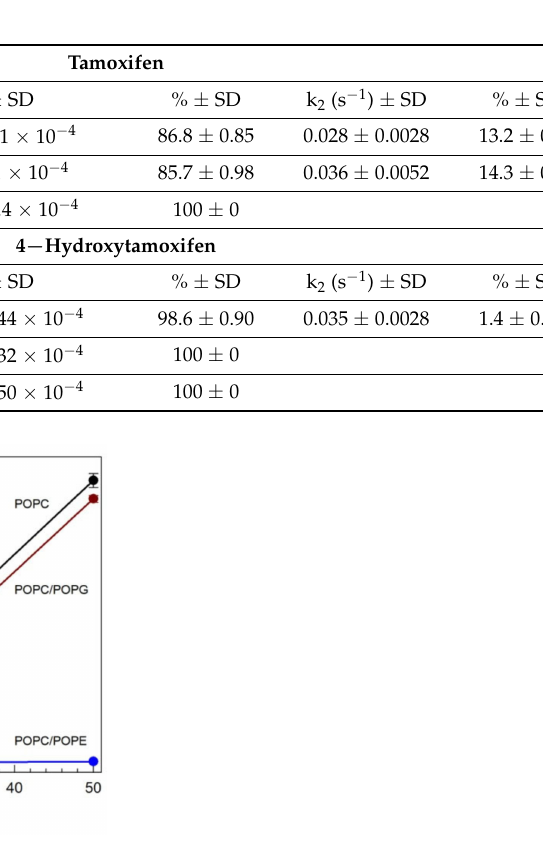
Figure 5. The initial rates of TMXinduced CF leakage as a function of TMX concentration. Initial rates were determined from the curves shown in Figure 3, for LUV composed of POPC (black), POPC/POPG 5:1.7 (red), or POPC/POPE 5:1.7 (blue). The inset shows a close-up view of the plot corresponding to the POPC/POPE composition. S.E. bars are shown when bigger than the